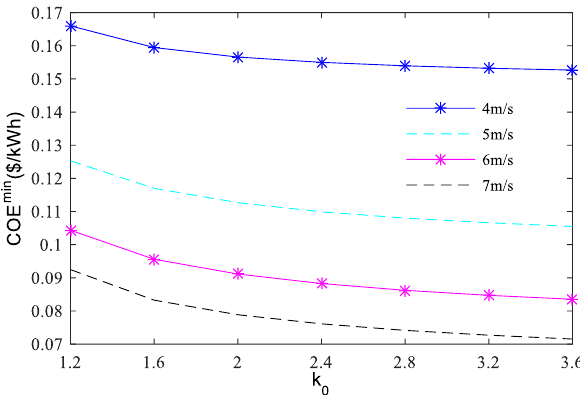
Figure 3. The minimum COEs versus the annual mean wind speeds and the shape factors.